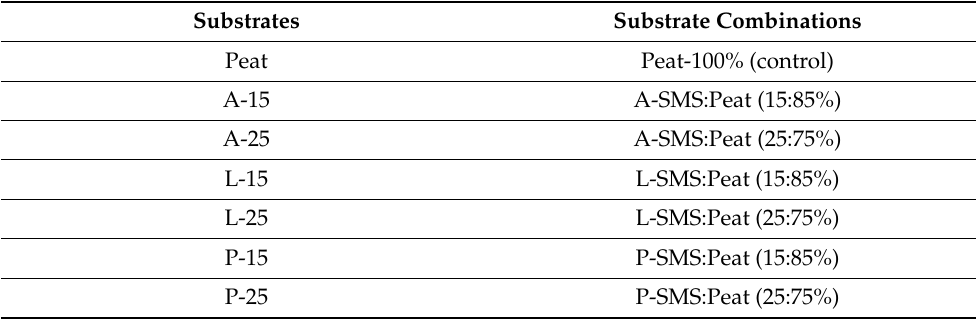
Table 2. The substrates evaluated in the study as growing